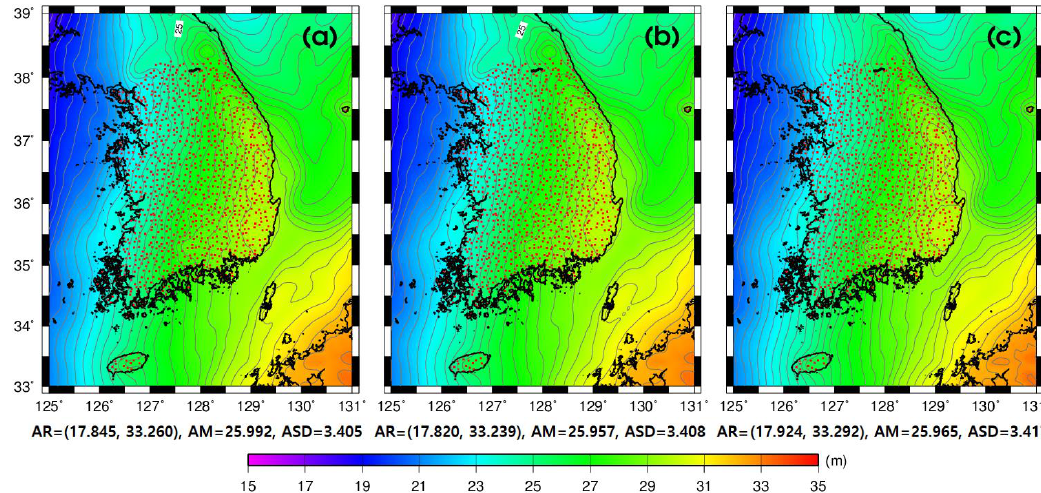
Figure 3. The 1′ gridded geoid heights (𝑁 𝐾𝑁𝐺𝑒𝑜𝑖𝑑 ) derived from the three KNGeoid models developed by NGII. ( a ) KNGeoid13; ( b ) KNGeoid14; and ( c ) KNGeoid18. The red dots represent the locations of the 1182 GNSS/leveling UCPs.